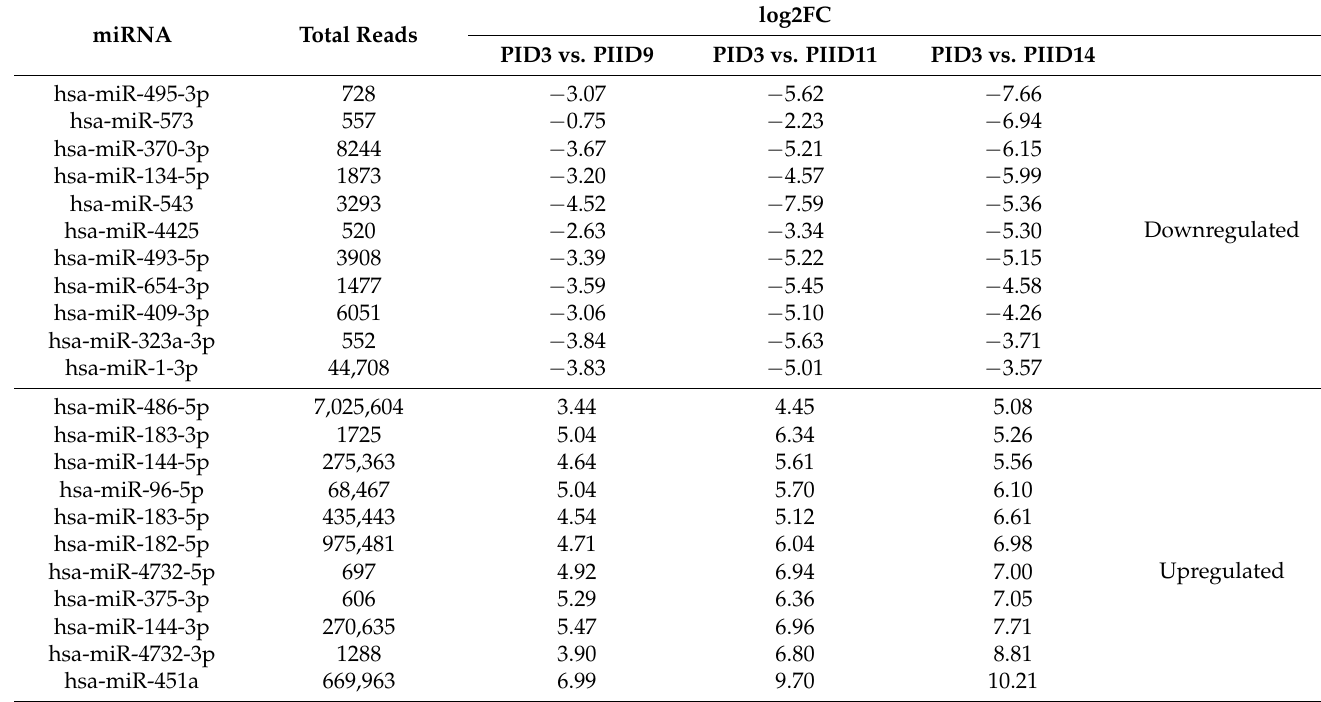
(PID3 denotes the cells from Phase I Day 3 of the culture, and PIID9, PIID11 and PIID14 represent the cells from Day 9, Day 11, and Day 14 of Phase II of the culture,